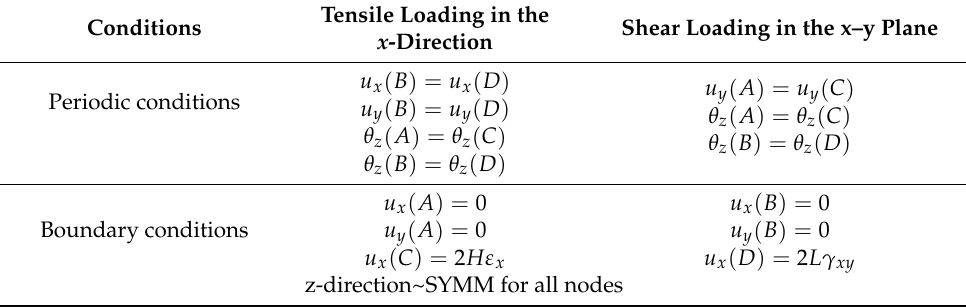
Table 1. Periodic and boundary conditions applied to the unit